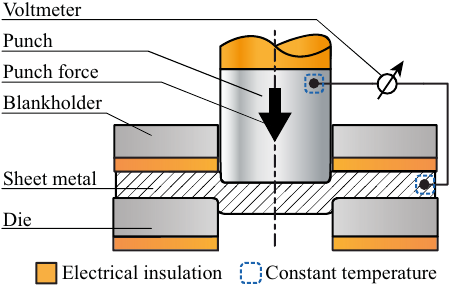
Fig. 2. Schematic drawing of a tool – workpiece thermocouple for temperature measurement during embossing and blanking operations.